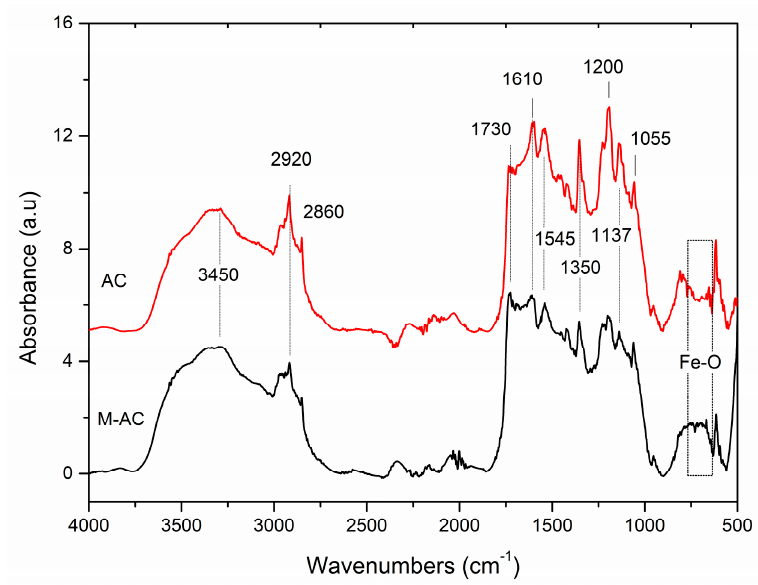
Figure 1. FTIR spectra of tire waste-derived activated carbon (AC) and magnetic AC (M-AC).